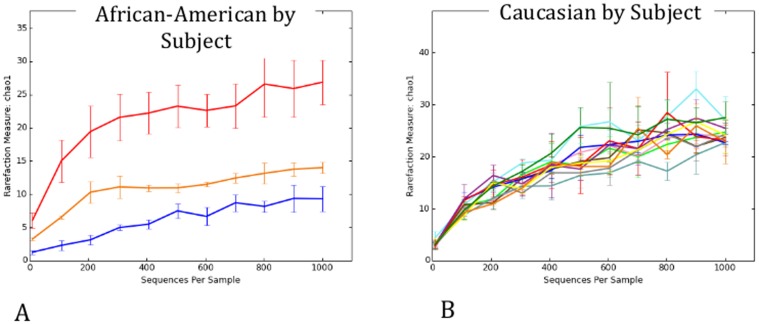
Estimation of species richness according to Chao 1 index.A – African-American subjects (Red – N009, Orange – N018, Blue – N017). Diversity between subjects is significant and therefore does not allow for the grouping of the subjects for analytical purposes. B – Caucasian subjects. No significant differences in diversity were found among subjects.